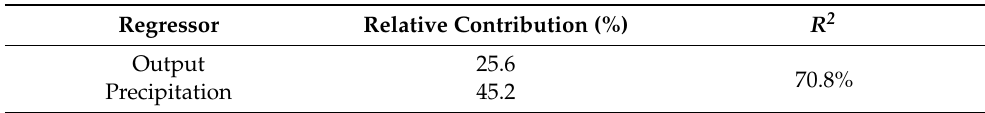
Table 13. Relative contribution of WEC regressors (%).